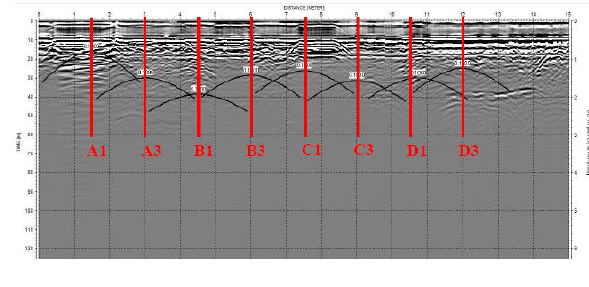
Figure 9 . GPR calibration result